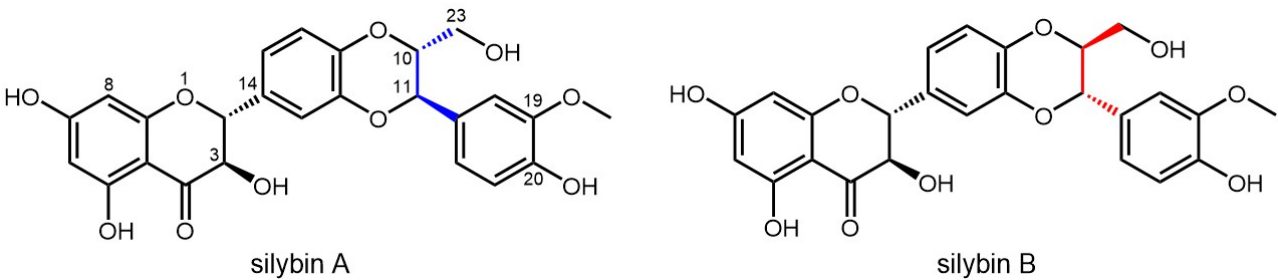
Figure 1. Diastereomers of